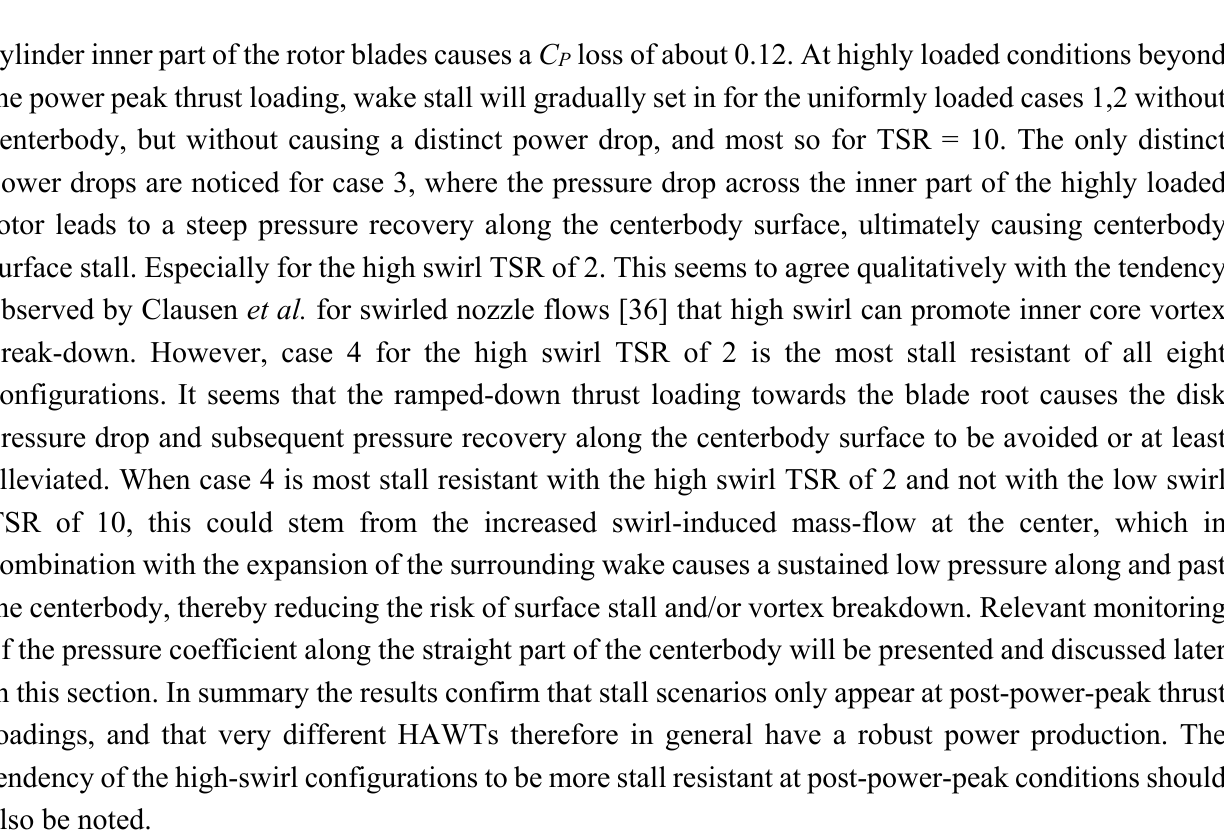
(cid:3404) 0.96 (cid:2904)